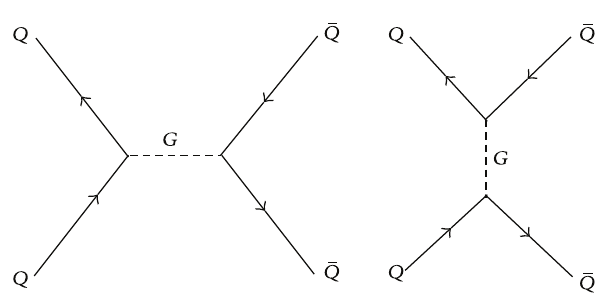
Figure 3: Scattering diagrams for 𝑡 - and 𝑠 -channel Goldstone boson 𝐺 exchange between 𝑄 and 𝑄 quarks. Analogous diagrams can be drawn for 𝑔 (and 𝐻 )